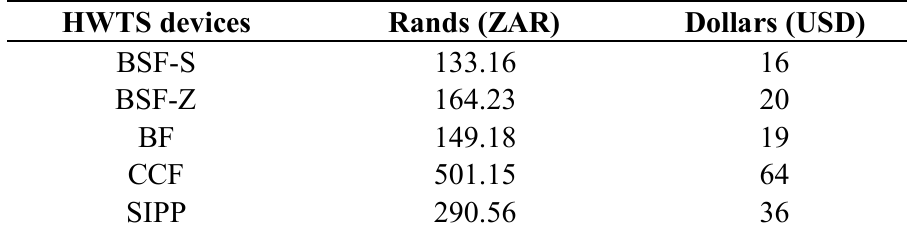
Table 2. Total manufacturing costs of household water treatment